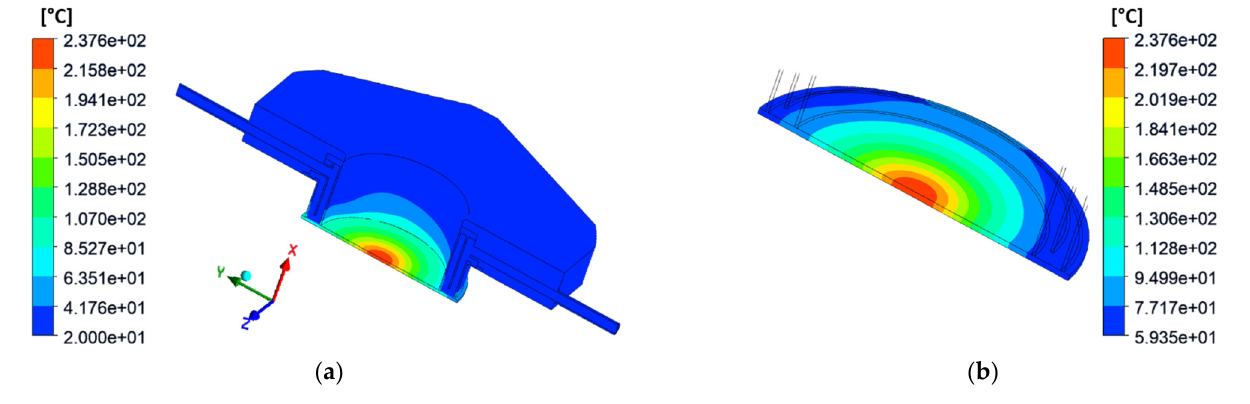
Figure 4. ( a ) Contour plot of the temperature distribution in the window; ( b ) detailed view of the temperature distribution in the diamond disk.